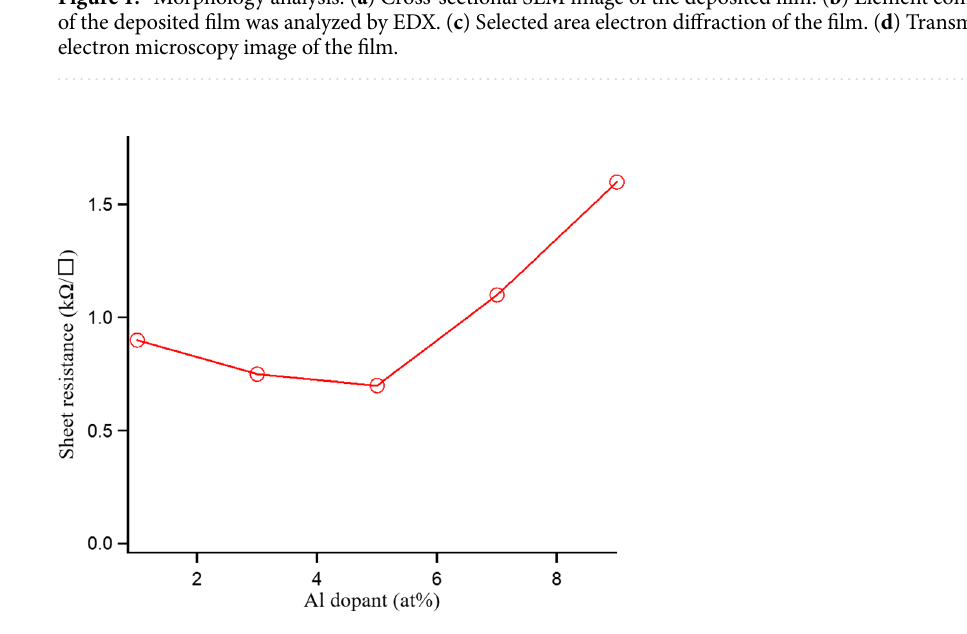
Figure 2. Dependency of the sheet resistance of AZO film by ALD on aluminum dopant